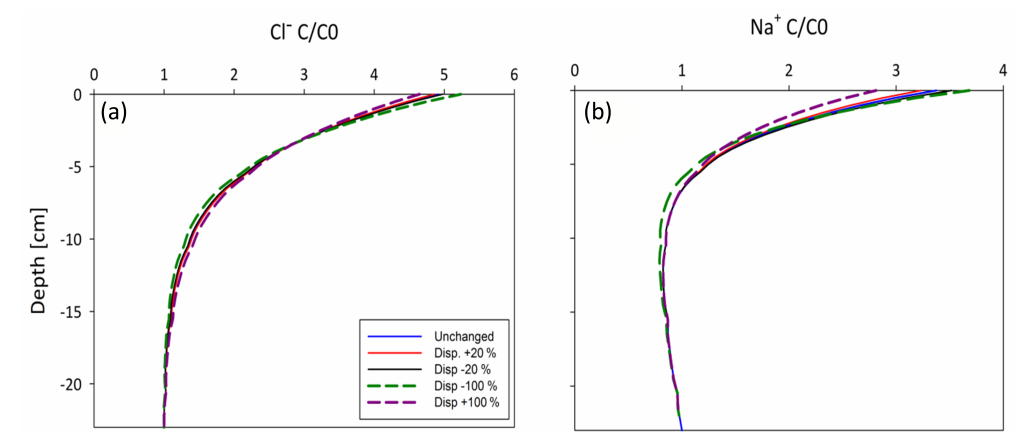
Figure 8. Sensitivity analysis of unsaturated transport for changes in the dispersion coefficient. (a) in Cl − transport, (b) in Na + .